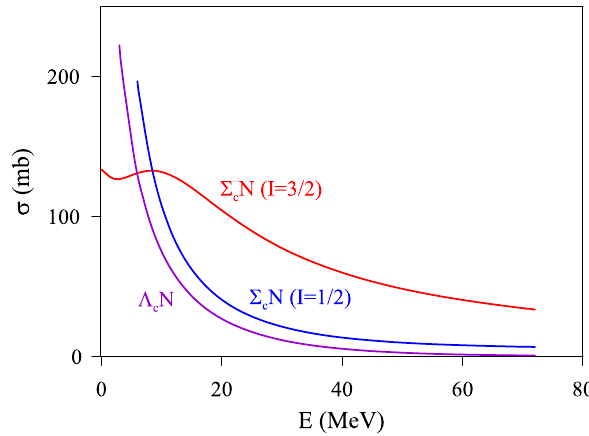
Fig. 8 Total cross section for the (cid:2) c N (purple line), (cid:3) c N ( I = 1 / 2 ) (blue line) and (cid:3) c N ( I = 3 / 2 ) (red line) scattering. E = 0 stands for the (cid:2) c N or (cid:3) c N